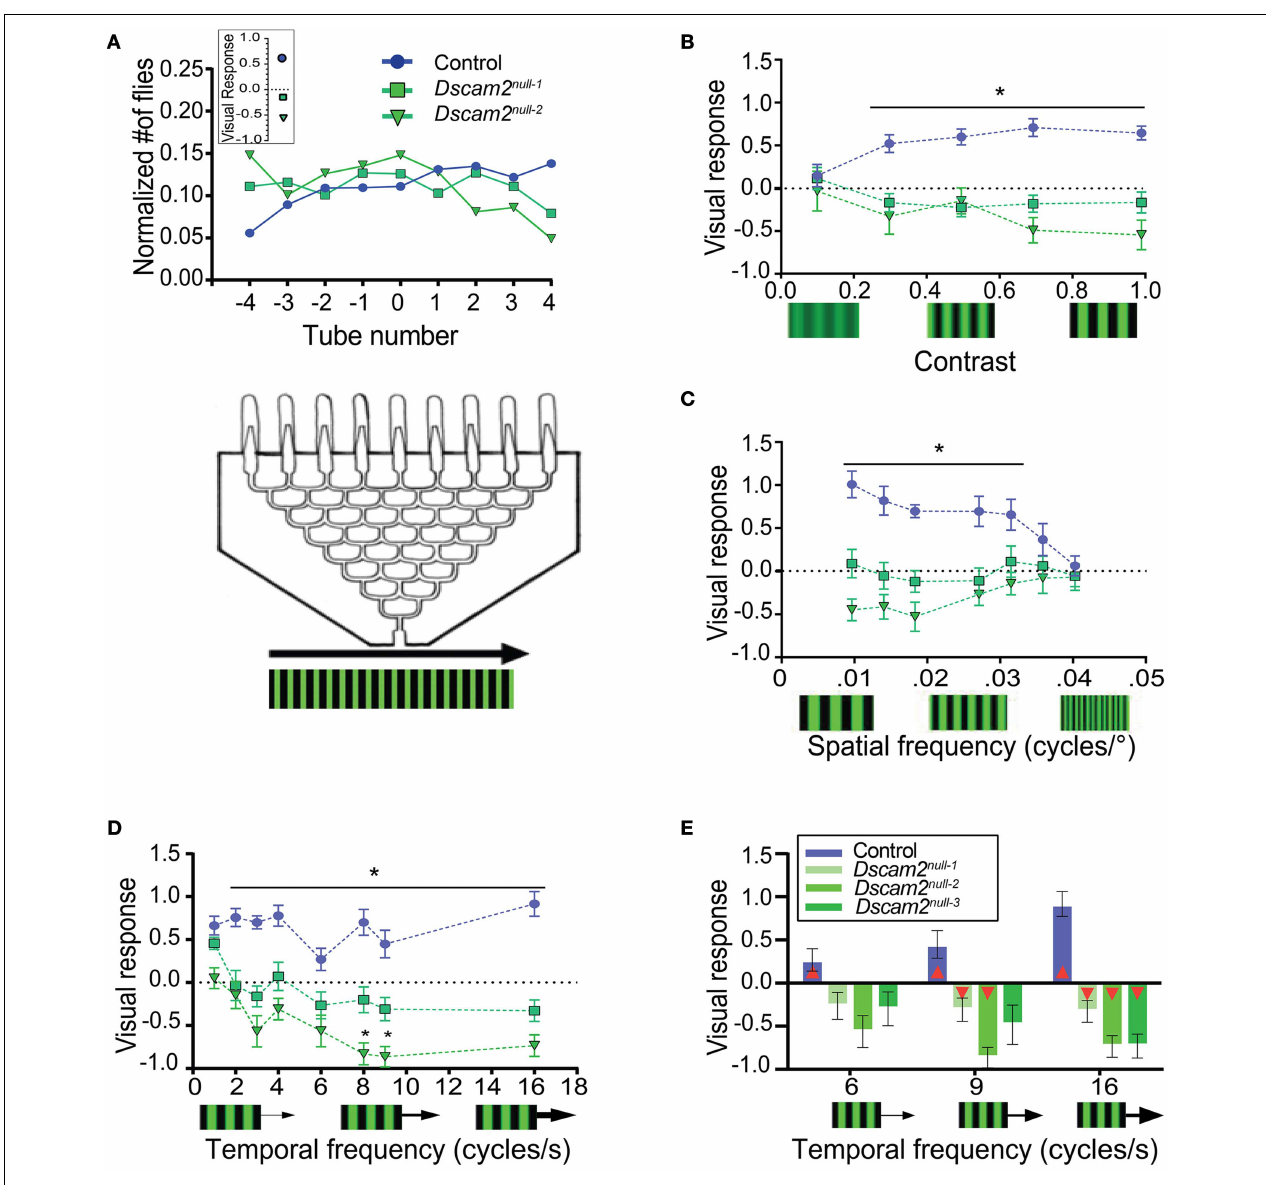
FIGURE 3 | Dscam2 mutants have a weakened and inverted response to motion in the population visual response assay. (A) Population visual response assay. The same maze that was used for the phototaxis assay was placed on LED panels displaying moving gratings. The line graph displays the normalized distribution of flies in the maze. On average, control flies follow the direction of motion, resulting in a positive visual response. Dscam2 mutants exhibit the opposite behavior, resulting in a negative response. The inset represents the calculated visual response for each genotype (see